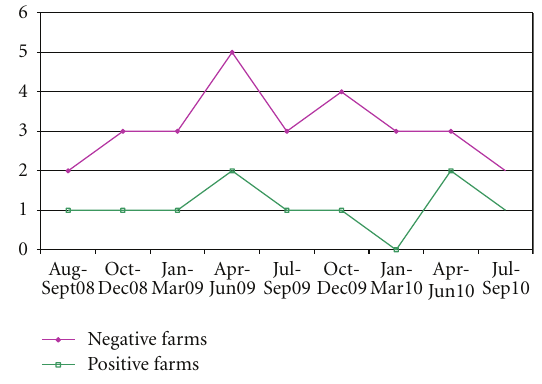
Figure 5: Seasonal distribution of MAP seropositive and seronega- tive farms in the two provinces.